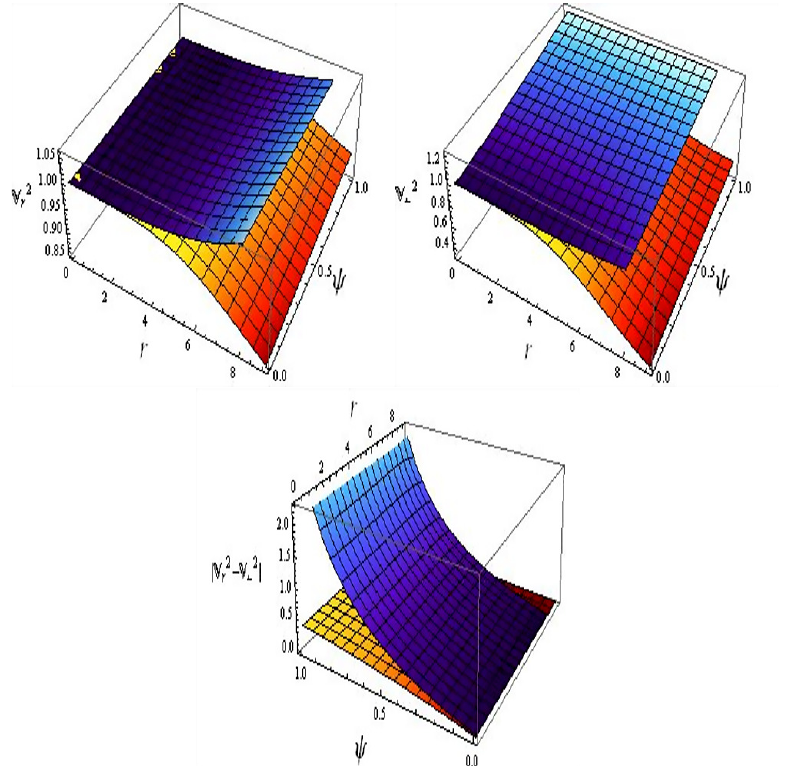
Figure 3. Plots of causality condition and Herrera cracking approach versus ψ and r corresponding to two stellar candidates (Solution I).